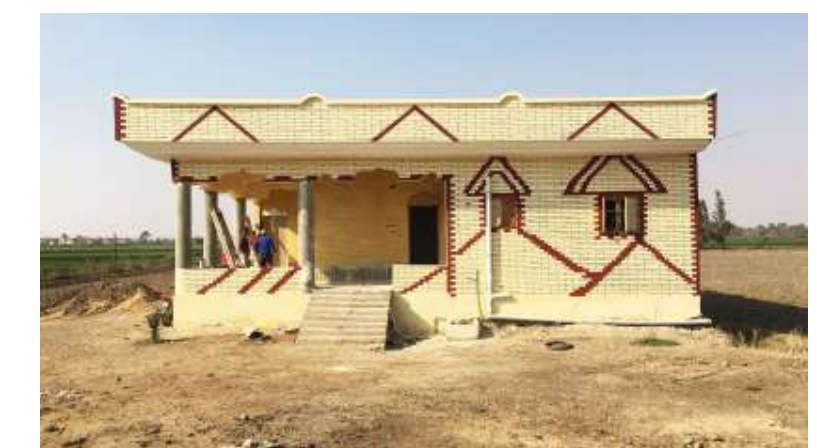
Figure 12 Examples of painted bricks